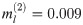
Bulges drive selection by “pushing” out-flow boundaries.The panels show the motion of an out-flow boundary due to the expansion of the bulges formed at the surrounding in-flow boundaries. Initially, the bulges are small (AB). Bulge growth has no effect, until one of the bulges comes in contact with the boundary of interest (C). After that, the expansion of the bulge displaces the out-flow boundary (D). The movement of the boundary stops when it is locked between two nearest bulges (EF). The relationship between the location of bulge and the motion of the out-flow boundary is further clarified in schematics above each of the panels. The black lines in the last panel show the locations (but not the actual size) of the bulges at earlier times. To illustrate the dynamics most clearly, we chose the model parameters in the no-mixing regime (see Fig 8). As a result, both in-flow and out-flow boundaries appear almost equally sharp. The chirality of the strains is shown with thick white arrows. Here, m0 = ms = mb = md = 0, g = 0.1, N = 200 for both strains. ml(2)=0.009, mr(2)=0.001, ml(2)=0.001, mr(2)=0.009 on a lattice of 2400x6400 sites.